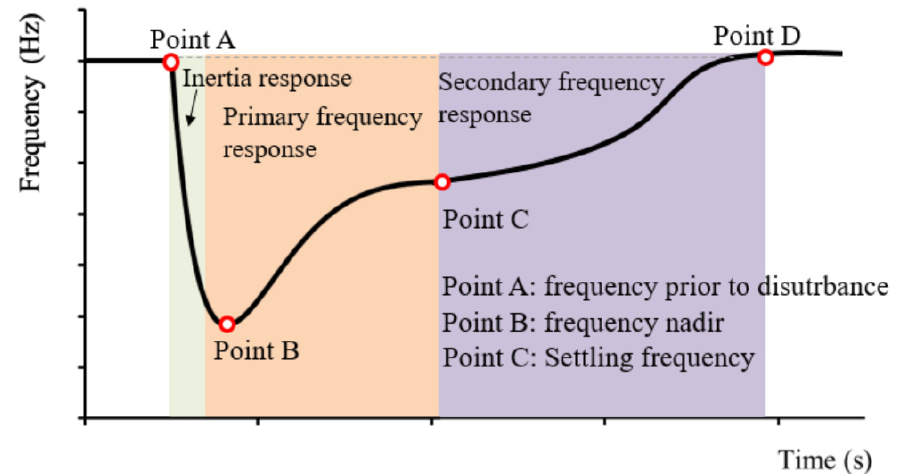
Figure 1. Frequency response of traditional synchronous generator following a power imbalance.